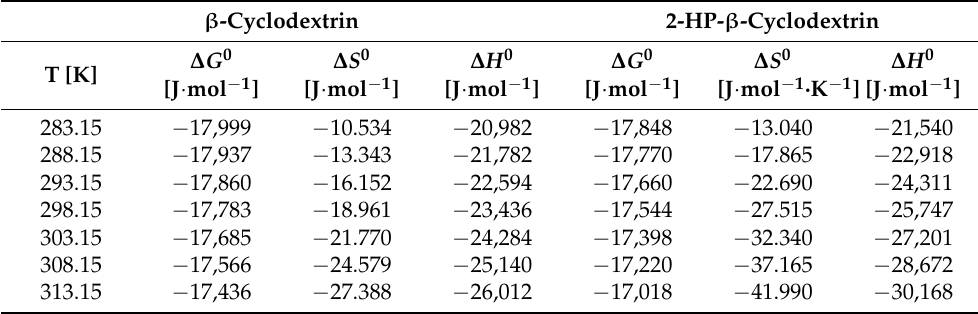
Table 7. The values of thermodynamic functions ∆ G 0 , ∆ S 0 , ∆ H 0 [J · mol − 1 ] for β -cyclodextrin and 2-HP- β -cyclodextrin with the salt of trans -caffeic acid.